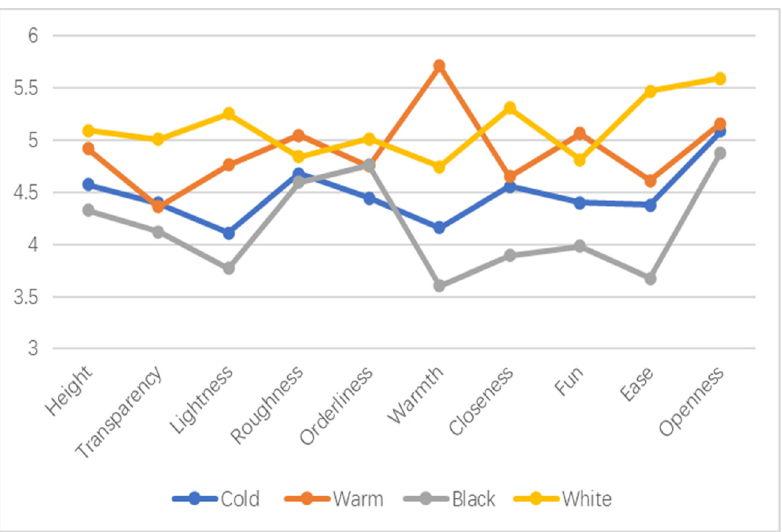
Figure 3. Mean value of color